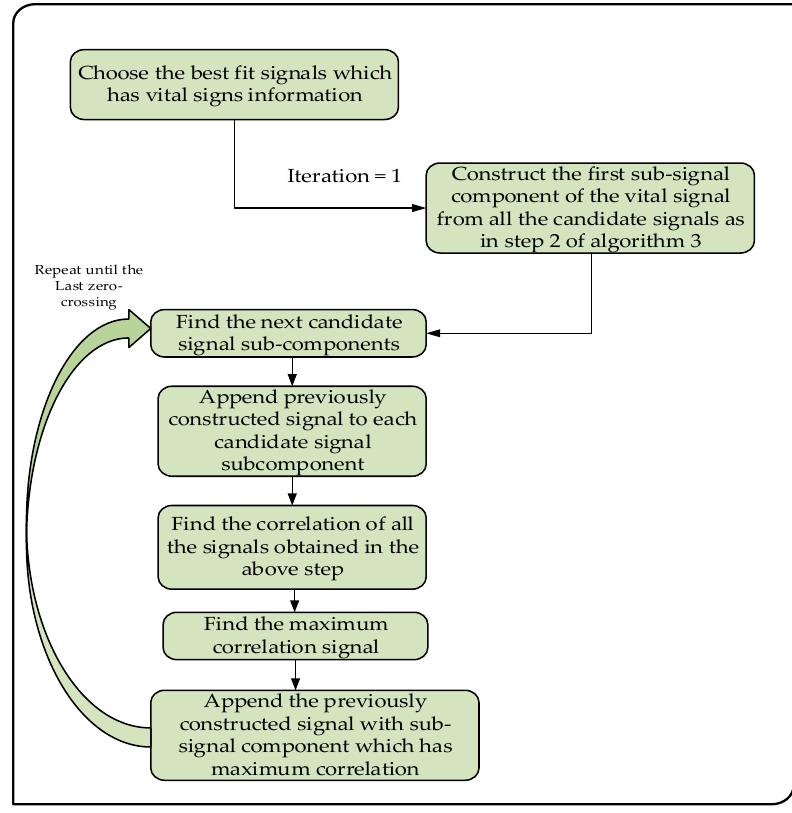
Figure 7. The vital signal construction from the candidate sub-signal components of the best fit signals.